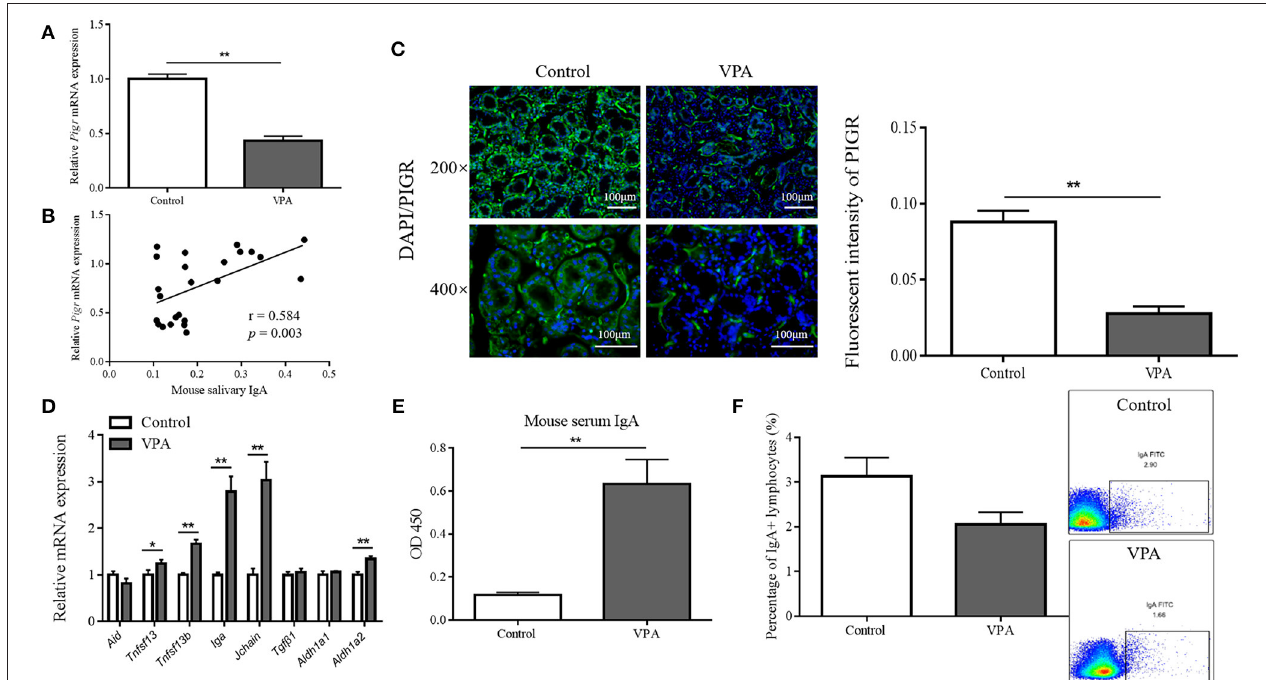
FIGURE 5 | The polymeric immunoglobulin receptor ( Pigr ) levels in mouse submandibular glands and the correlation of which with the mouse salivary immunoglobulin A (IgA) content. (A) The qRT-PCR result of the relative mRNA level of Pigr in the submandibular glands of valproate acid (VPA) mice and control mice ( n = 5 per group, Mann-Whitney U-test). (B) The Pearson’s correlation analysis of the relative Pigr mRNA level and mouse salivary IgA content. (C) The PIGR protein level in the submandibular glands of VPA mice and control mice confirming by immunofluorescence staining and the quantification results (measuring with fluorescence intensity at 400 × magnification, n = 5 per group, Student’s t -test). Representative images of similar results are shown. (D) The qRT-PCR results of the relative mRNA levels of genes regulating IgA class-switch recombination, IgA synthesis, and the IgA response in the submandibular glands of VPA mice and control mice ( n = 5 per group, Mann-Whitney U-test and Student’s t -test). (E) The IgA content (presented as optical density at 450nm) of mouse serum samples was measured by enzyme-linked immunosorbent assay ( n = 5–6 per group, two replicate experiments, Mann-Whitney U-test). (F) Flow cytometry results showed the percentage of